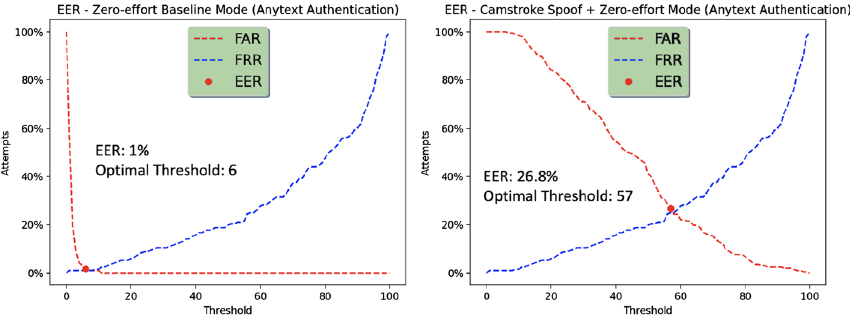
Fig. 17 EER comparison for freetext-mode, before attack (left) and after the attack (right)